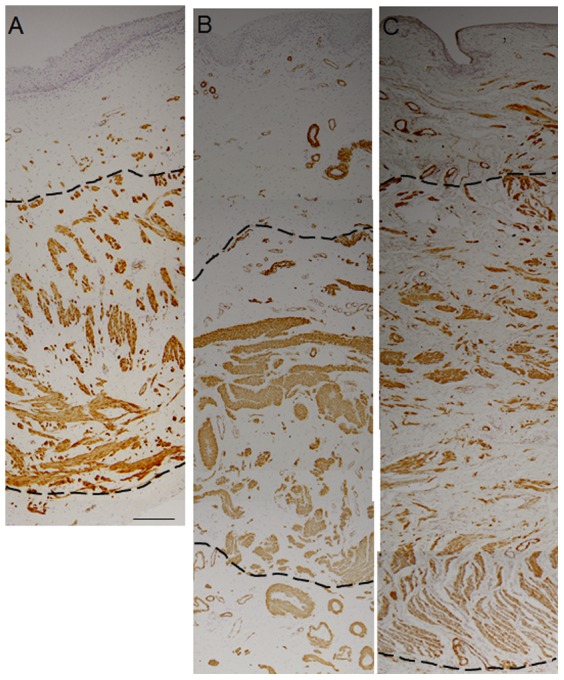
αSMA immunohistochemical staining of ovine vaginal wall.A. virgin, B. parous, C. pregnant ovine vaginal tissue. Dotted lines indicate the muscularis layer. Scale bar 200 µm.